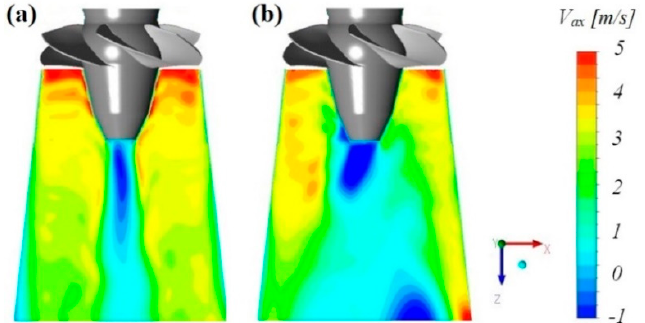
Figure 13. Axial velocity ( V ax ) in the draft tube at ( a ) the BEP and ( b ) PL. Results of the InletTotalPressure simulation.